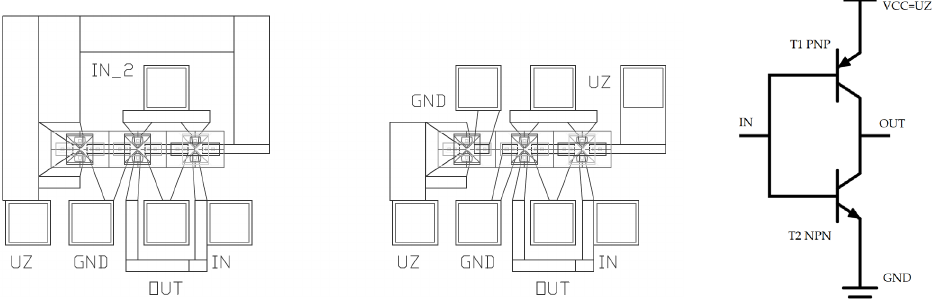
Figure 11. Inverter topography using prototype VES-BJT bipolar transistors. There were two variants with different power supplies and input paths. In each module on the prototype wafer, there were three pairs of structures, such as those shown in the figure. UZ—supply voltage, IN, IN2—inputs, OUT—output, GND—ground.